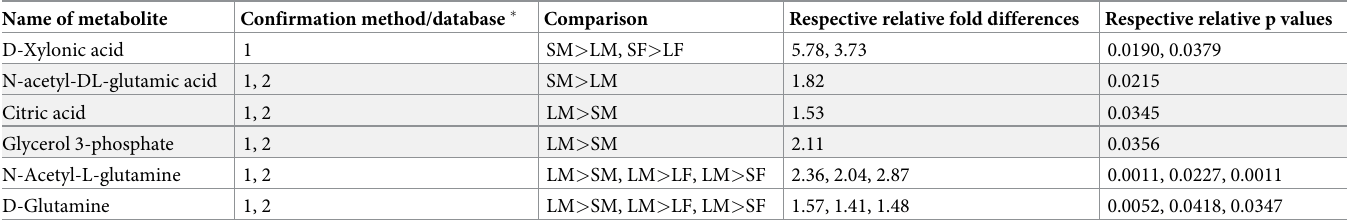
Table 2. Six metabolites were discussed in detail in this research. Highlighted metabolites were only different between the large and small male